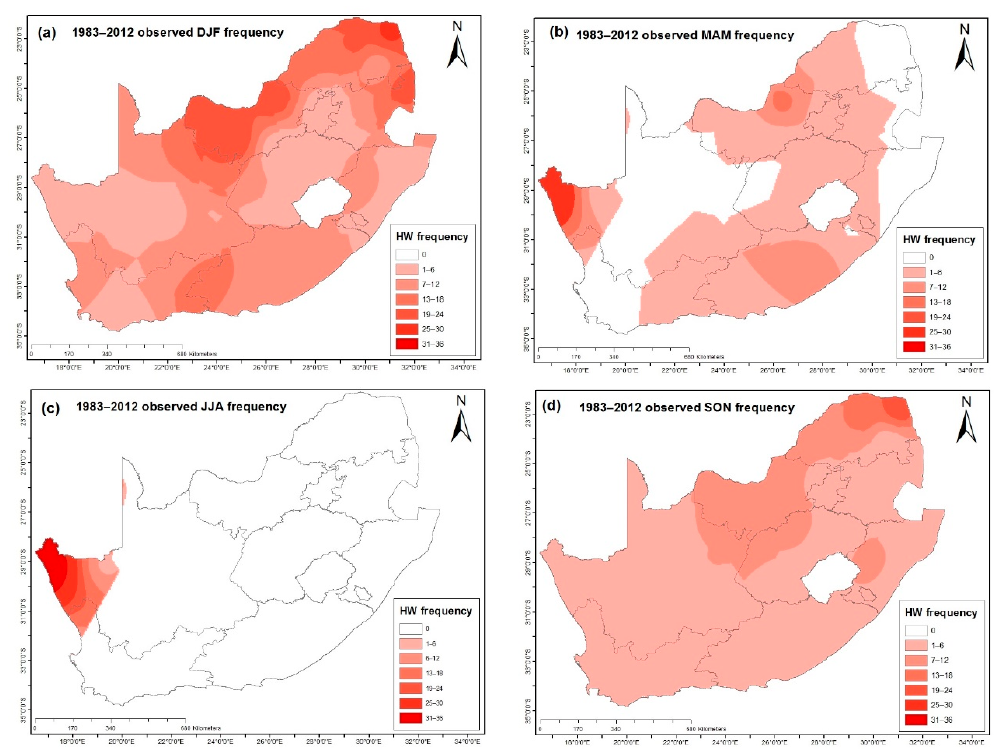
Figure 4. Observed HW frequency (total number of occurrence) across South Africa from 1983 to 2012 during ( a ) DJF, ( b ) March–May (MAM), ( c ) JJA and ( d ) September–November (SON).